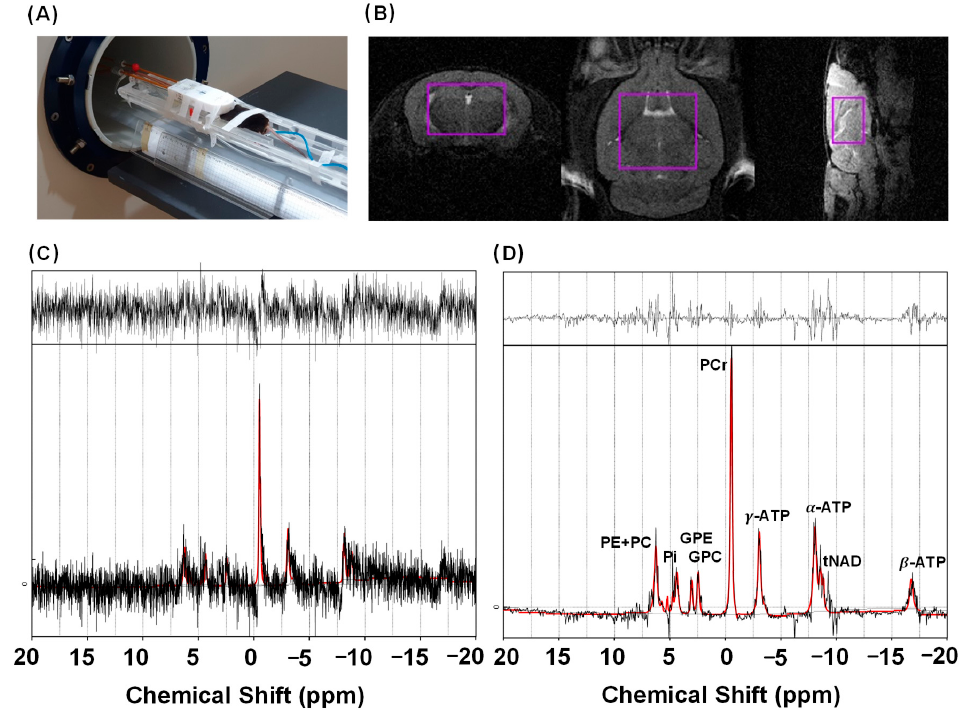
Figure 2. 31 P MRS data acquisition and analysis results. Mouse positioning ( A ), 31 P MRS voxel positioning of the inner brain region (violet color box) ( B ), LCModel analysis without denoising ( C ), and LCModel analysis with denoising ( D ). Note: in ( C , D ), the red lines represent LCModel spectral fitting results, and the black lines are target in vivo 31 P spectra (bottom) and residual signals (top). Table 2. CRLB and concentration differences between raw and denoised 31 P MRS data.